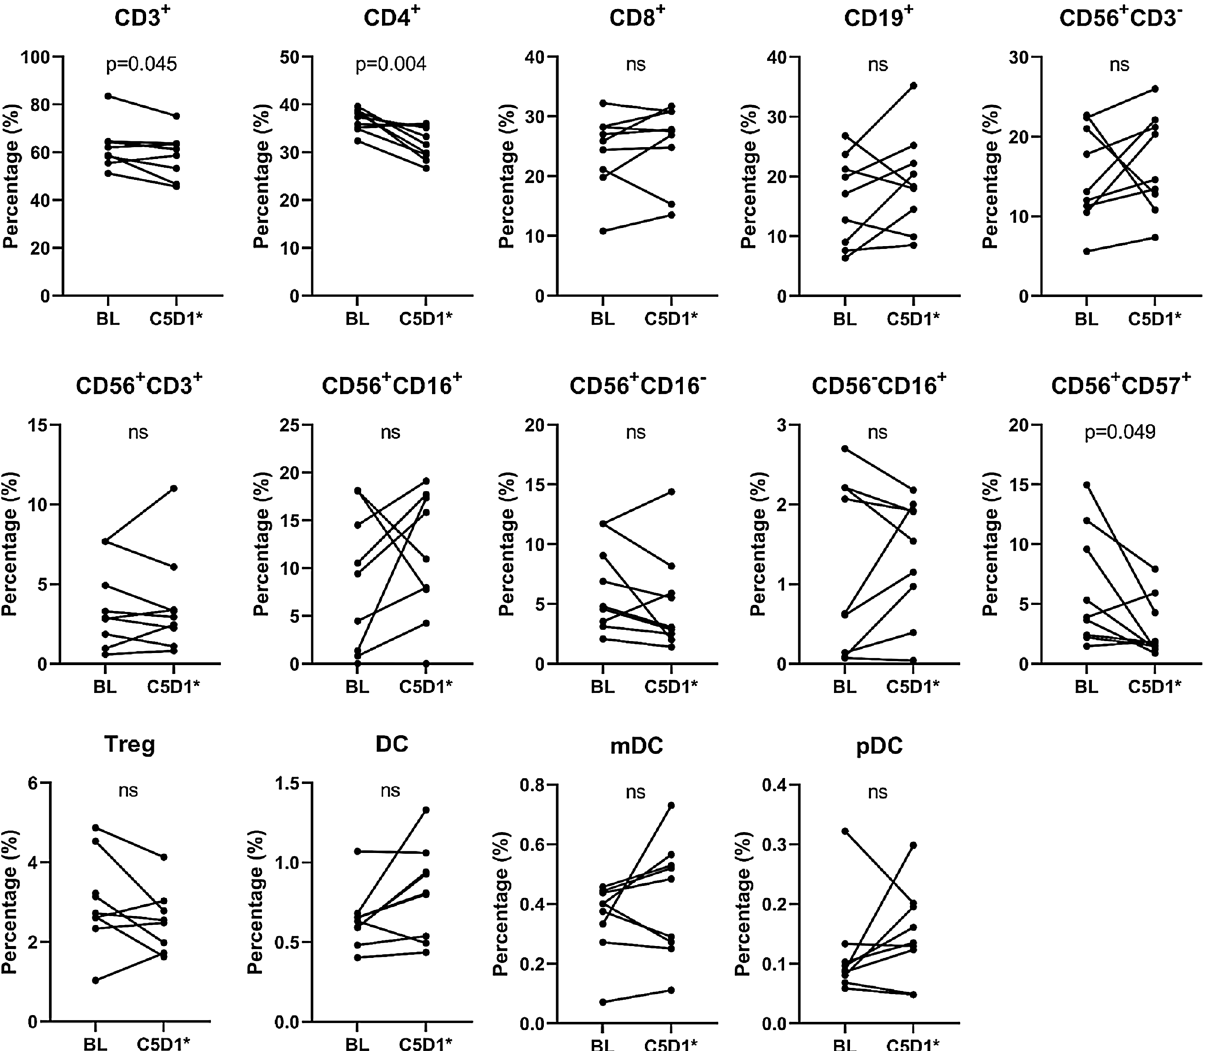
Figure 4. Changes in percentage of immune phenotype. BL baseline, C5D1 Cycle 5 Day 1, ns not significant. *One patient’s sample was collected before Cycle